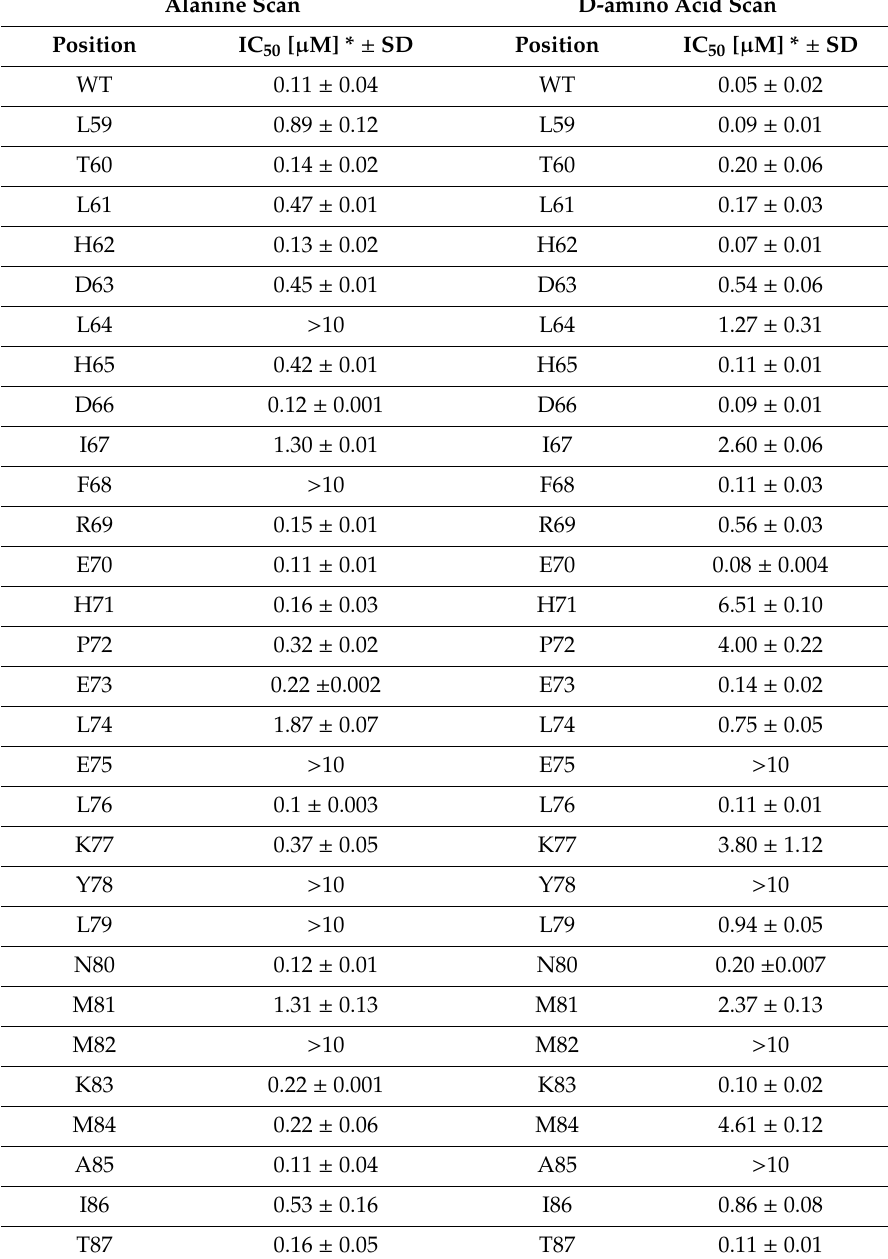
Table 1. Contribution of amino acid side chains and stereochemistry of the HCMV pUL53 hook peptide to its interaction with